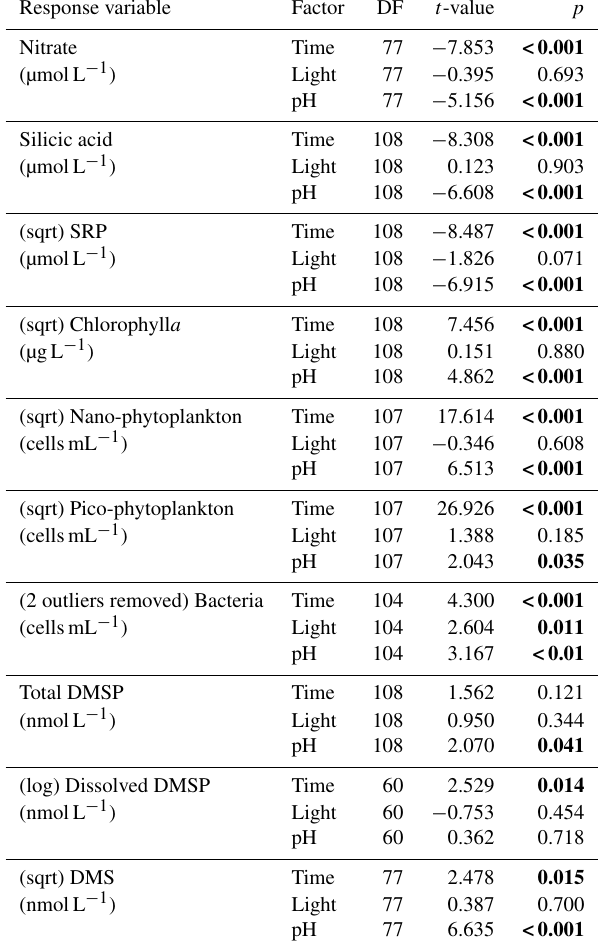
Table 3. Overview of the results of generalized least-square models testing for the effects of time, light, and pH T over the duration of the incubation on nitrate, silicic acid, soluble reactive phosphate (SRP), chlorophyll a , dissolved DMSP, total DMSP, and DMS concentra- tions, as well as nano-phytoplankton, pico-phytoplankton, and bac- terial abundances. Type of transformations applied to data when necessary are indicated in parentheses, significant results are indi- cated in bold, DF is the degrees of freedom, and p is the significance of the t -value.